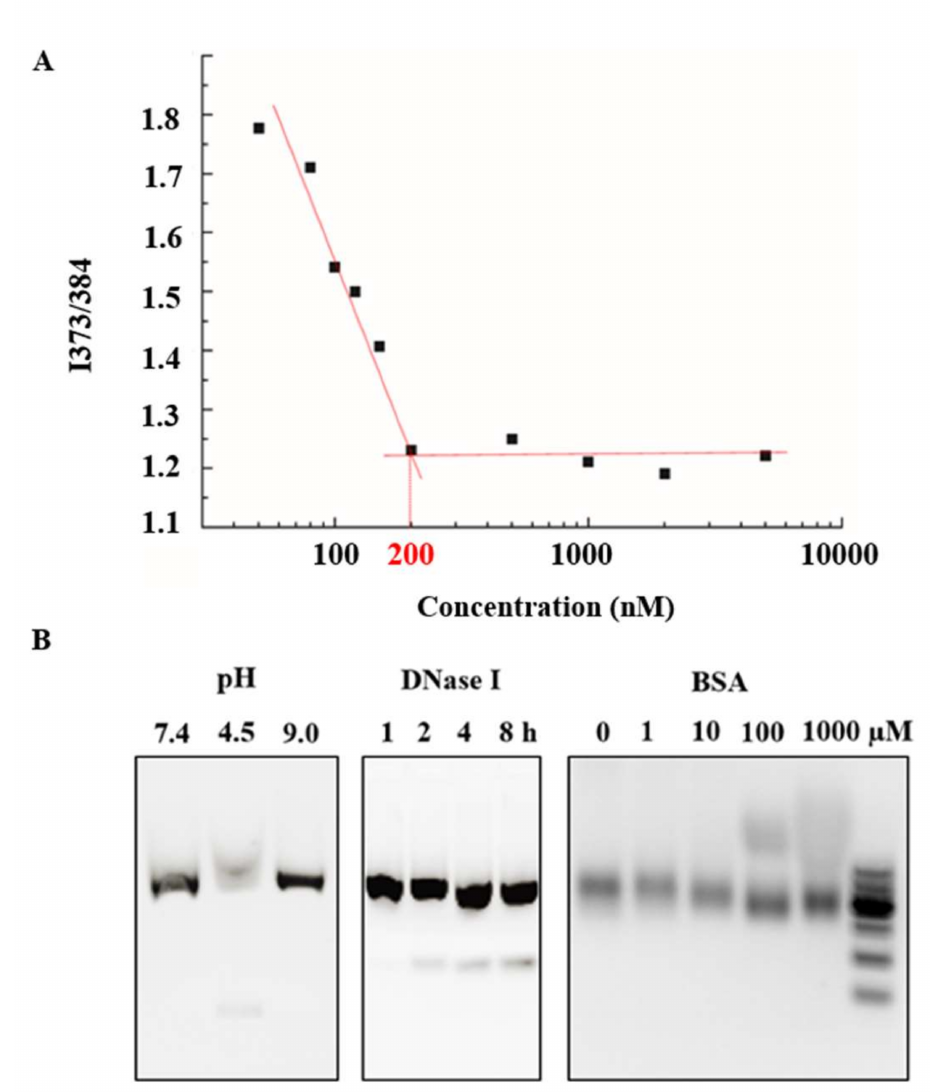
Figure 3. ( A ) CMC determined by pyrene fluorescence probe assay. ( B ) Stability study of affi-F/GQs in different pH, DNase I treatment time and BSA